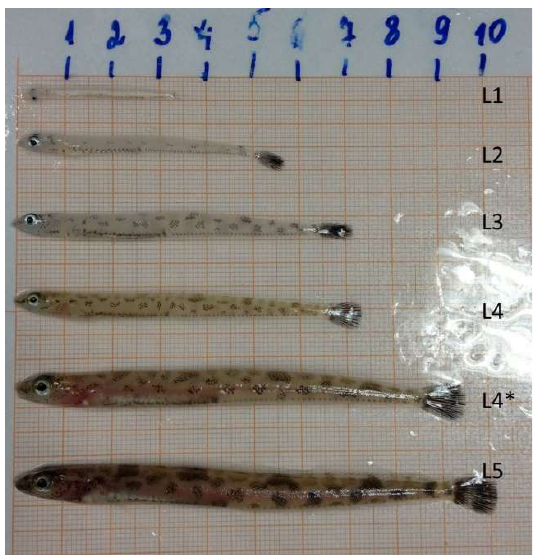
Figure 1. Stages of development of L. maculatus by Pekkoeva S.N., 2018 [29].